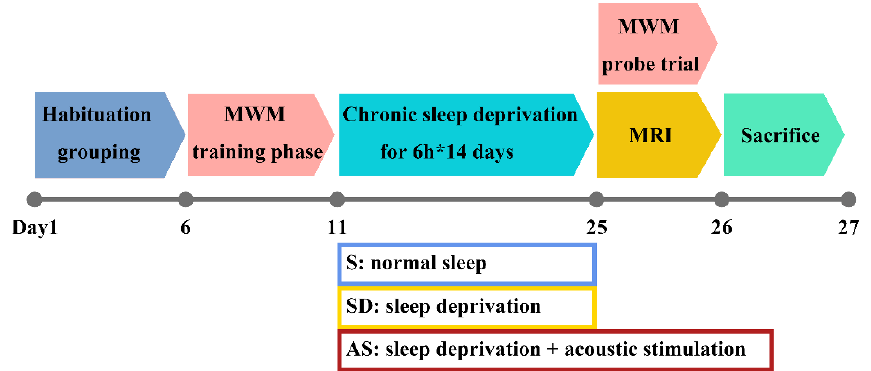
Figure 1. Timeline of experimental design. After habituation for 5 days and performing MWM training for 5 days, mice received 14-day sleep deprivation and acoustic stimulation according to grouping. Then, all groups underwent MWM probe trial and MRI scans. Following these examinations, they were sacrificed for pathology evaluation.